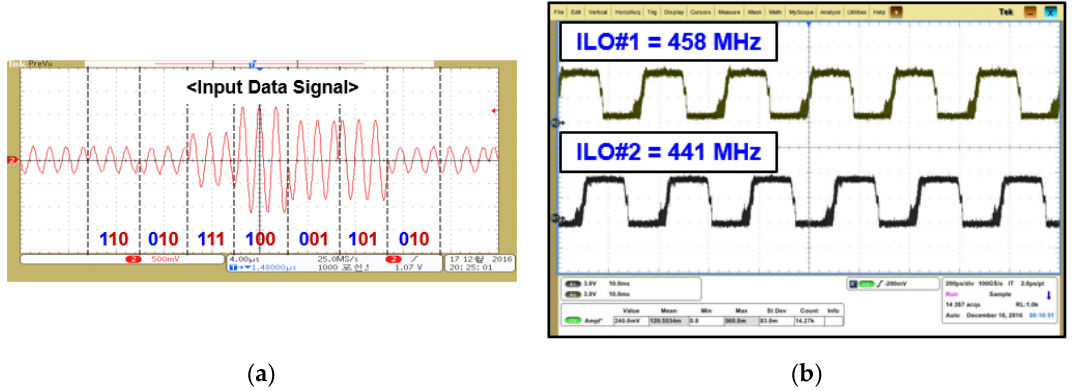
Figure 16. ( a ) Input data signal of phase detection path and ( b ) free-running frequencies of